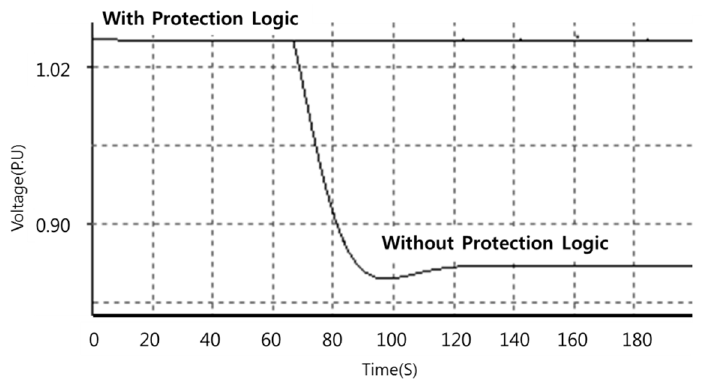
Figure 12. Result of protection logic at pilot point.